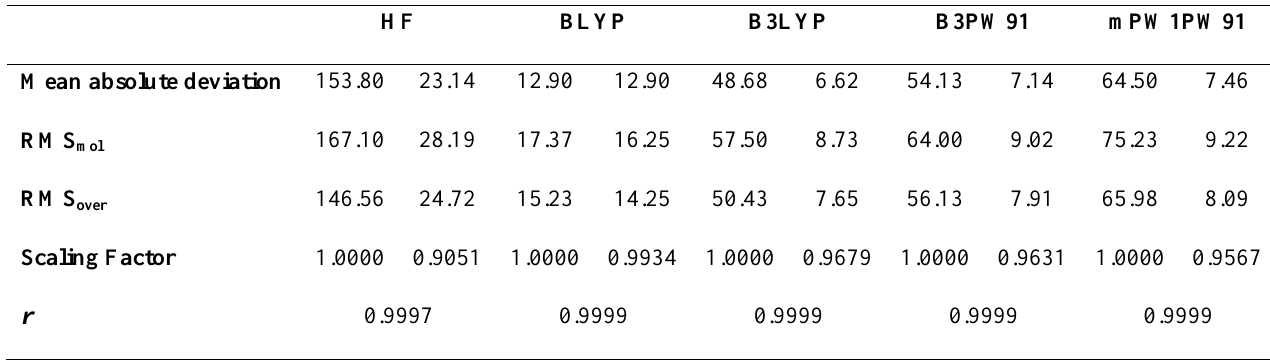
Table 4. Mean absolute deviation, correlation coefficient, and root mean square between the calculated and observed fundamental vibrational frequencies for the title compound.